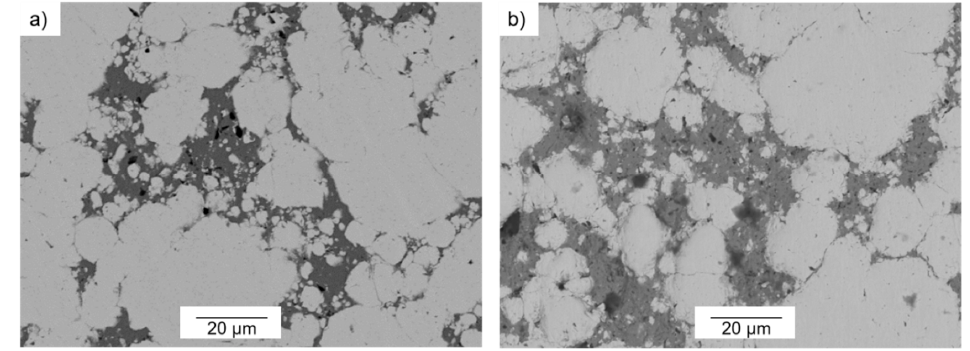
Figure 5. ( a ) Back Scattered Electron-SEM image of 80-W/20-Cu alloys prepared from bimodal powder 10-W f :90-W c , degasification time 10 s and hot consolidation time 90 s; ( b ) Back Scattered Electron-SEM image of 85-W/15-Cu alloys prepared from bimodal powder 10-W f :90-W c , degasification time 10 s and hot consolidation time 30 s.